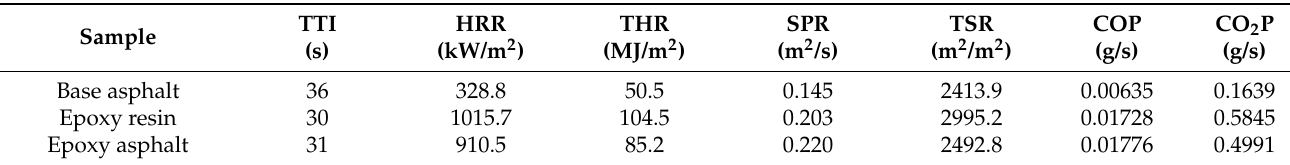
Table 5. Test results of the cone calorimeter test.